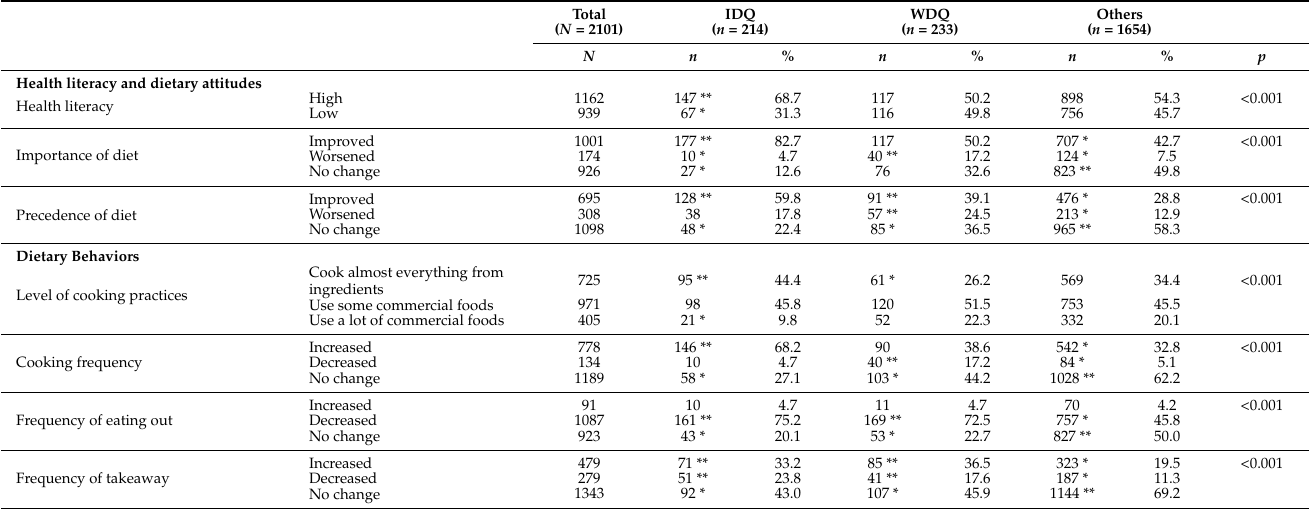
Table 3. Health literacy and current level of cooking practices as well as changes in dietary and lifestyle variables among participants according to changes in the diet